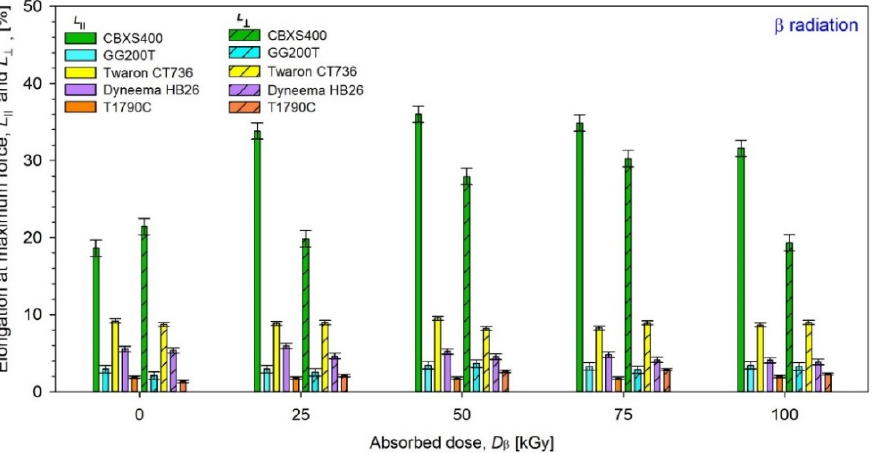
Figure 17. Elongation at maximum force of unmodified and β irradiated textiles.